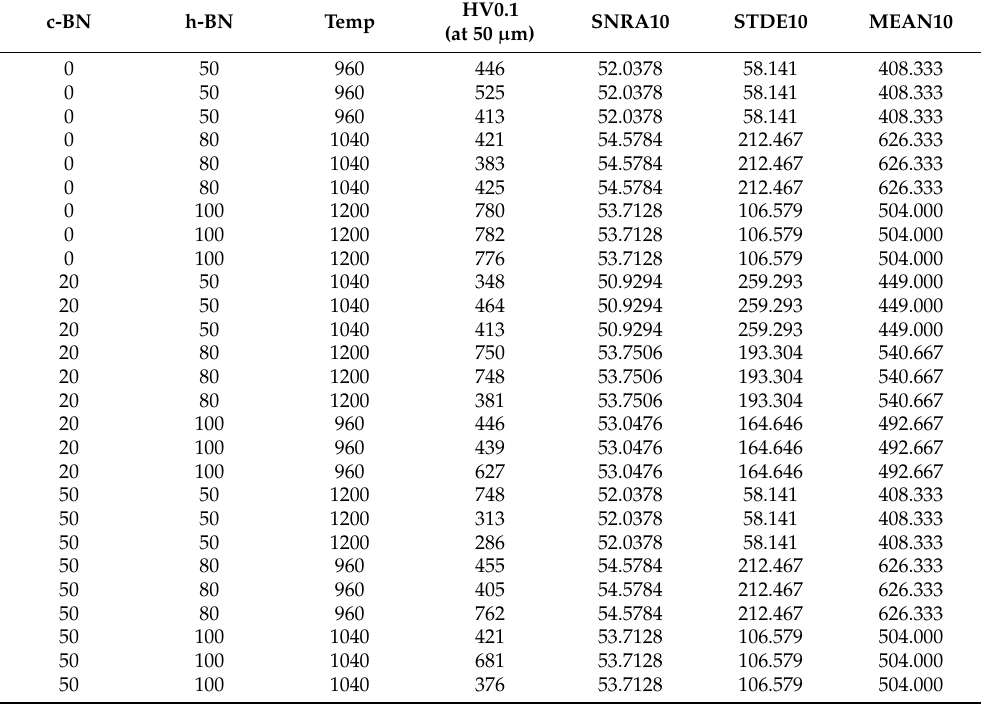
Table 6. Experiment results for microhardness and associated S/N